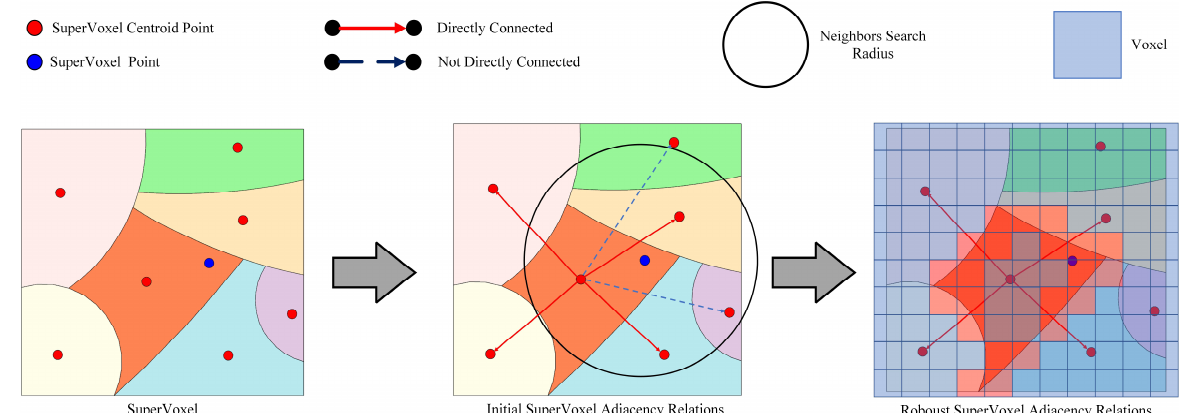
Figure 2 . Illustration of how to define the robust nieghborhood.